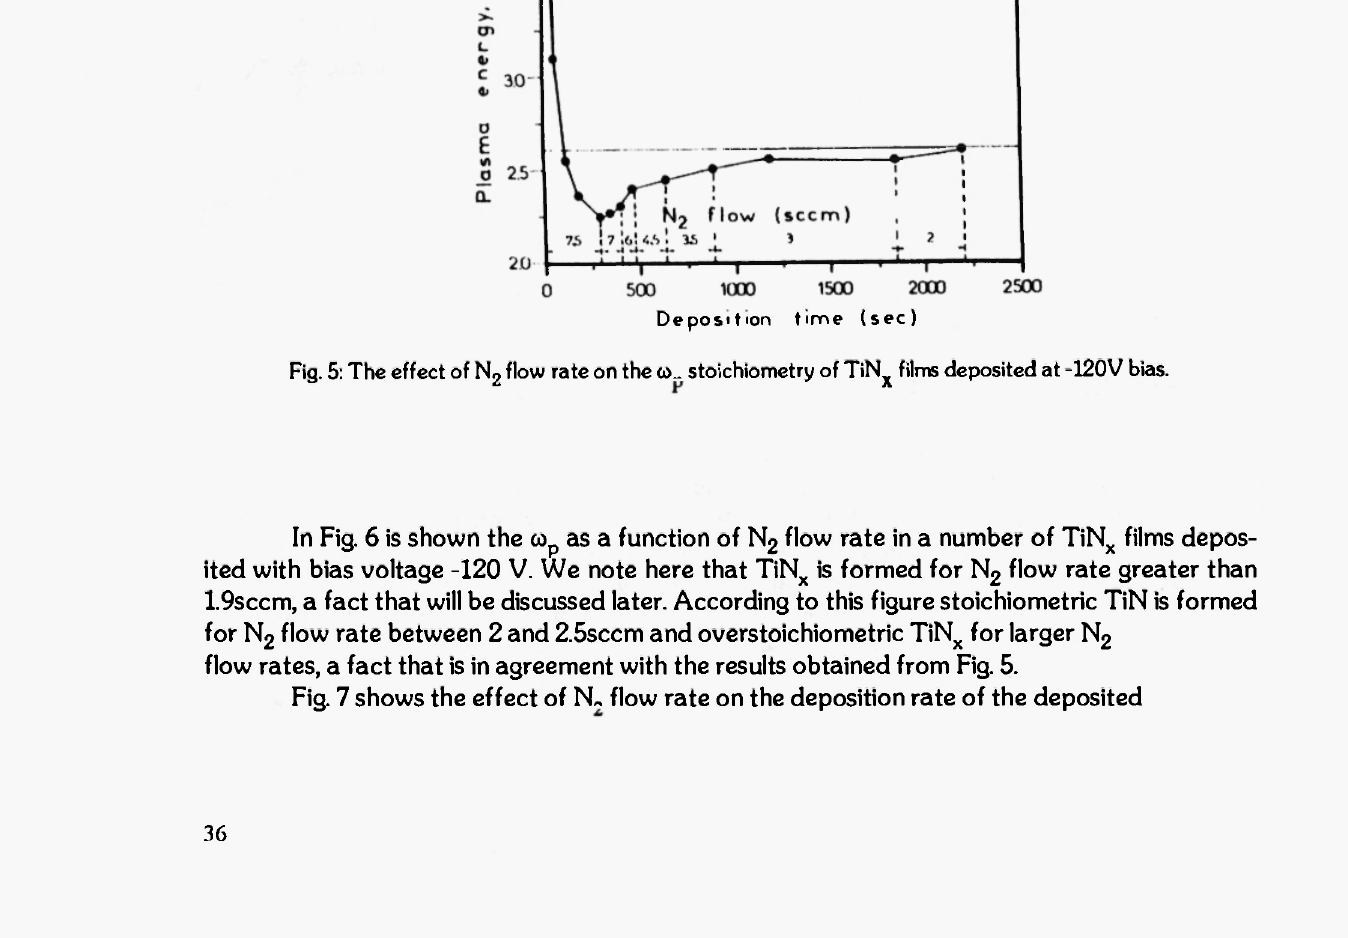
Fig. 5: The effect of N 2 flow rate on the ω stoichiometry of ΤίΝ χ films deposited at -120V